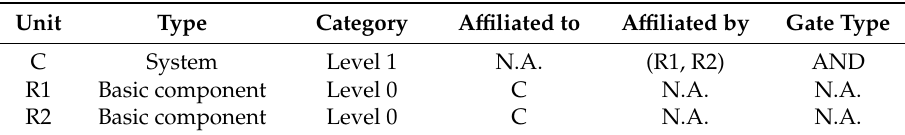
Table 2. A template of